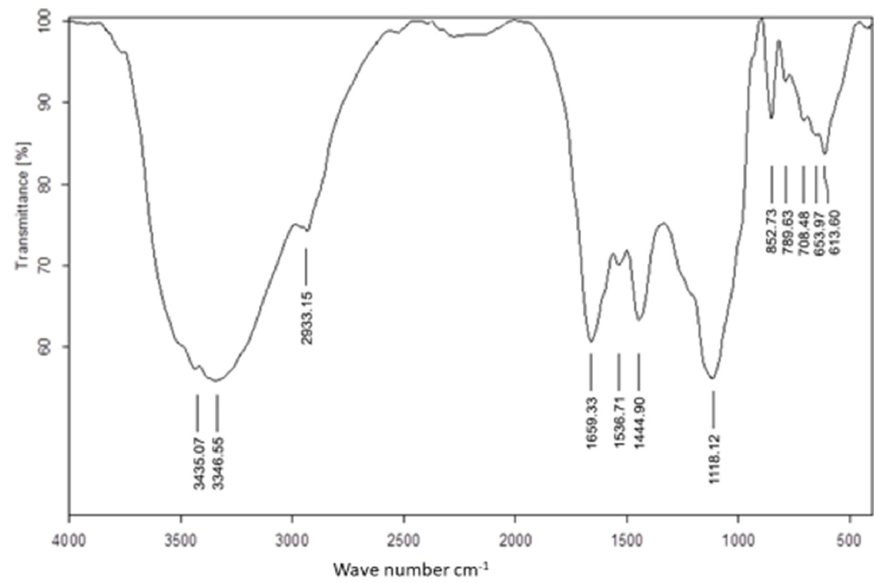
Figure 1. FTIR spectra of Ulva lactuca aqueous extract.